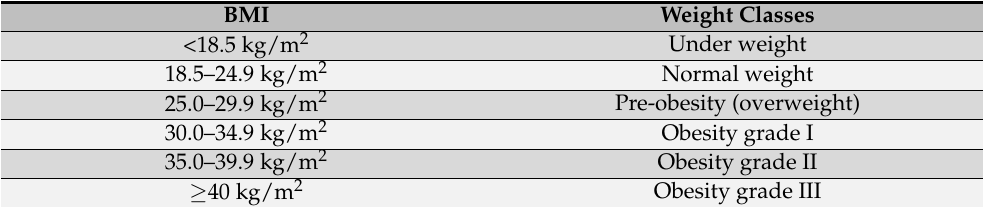
Table 1. Classification of weight classes based on the WHO scheme